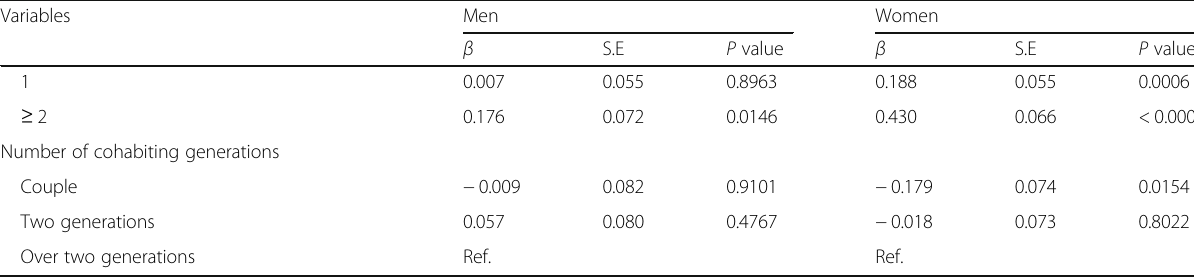
Table 2 Results of analysis of factors associated with CES-D 10 scores (Continued)